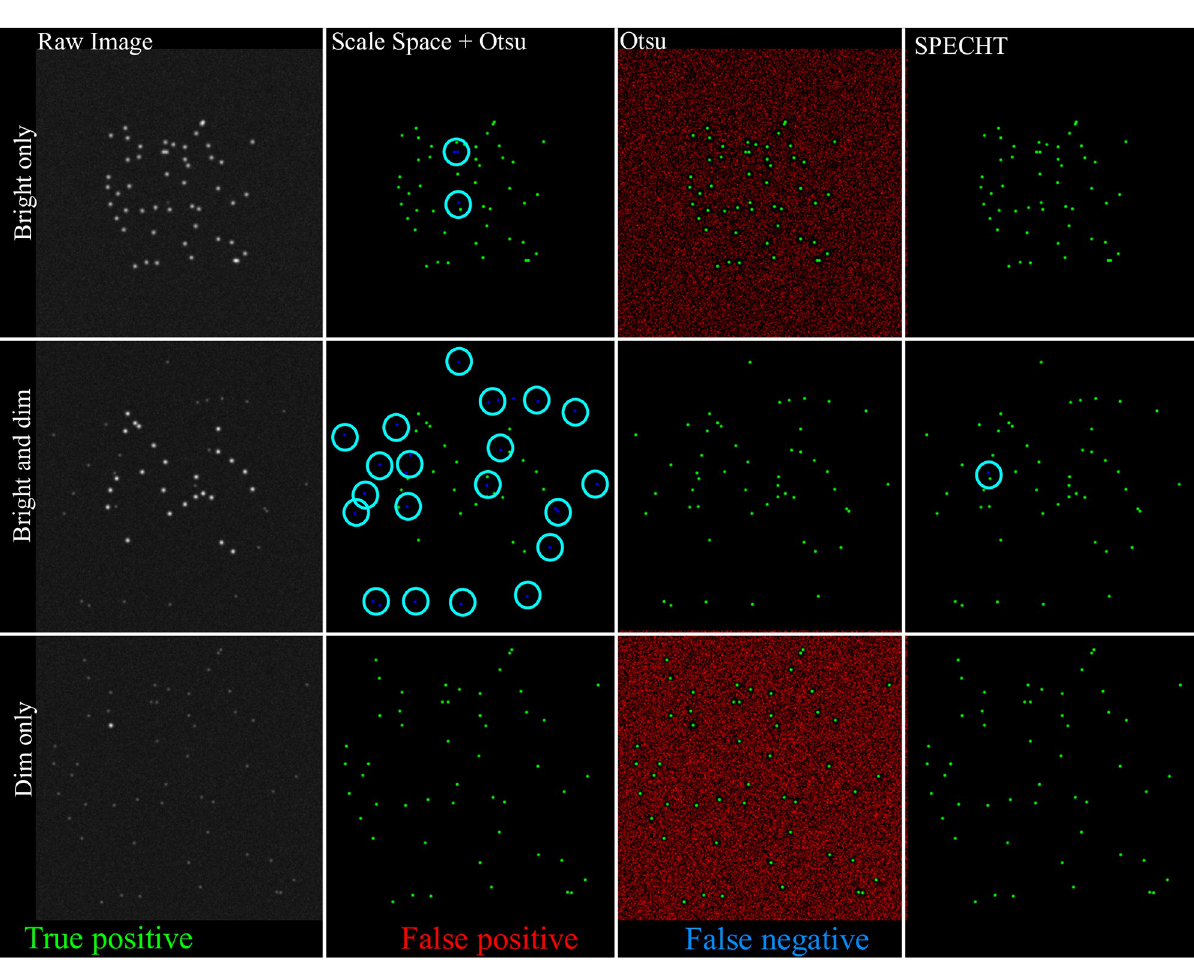
Fig 5. Consistency compared to existing methods. We simulate 3 markedly different in silico scenarios where light sources are either dominated by bright, dim, or are a mixture of both. Note that SPECHT is not always optimal, but does produce consistent results across these variable conditions. Green marks true positives, the location of the actual objects. Red marks false positives, predicted objects that do not exist. Blue circles denote false negatives, objects that should be detected, but are not.